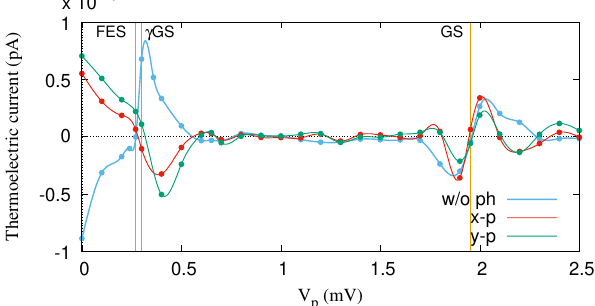
Figure 9. Thermoelectric current ( I L ) for the QD system without (w/o ph) (blue color) and with (w ph) x - (red color) and y -polarized (green color) photon fields. The photon energy is ¯ h ω γ = 1.68 meV, g γ = 0.05 meV, and ¯ n R = 1. The temperatures of the left and right leads are constant and fixed at T L = 1.16 K and T R = 0.58 K, respectively. The chemical potential of the leads are fixed at µ L = µ R = 1.2 meV. The golden vertical lines indicate the resonance condition for the GS at V p = 1.95 mV, and the Rabi-splitting states between the γ GS and the FES at V p = 0.271 meV. The weak external magnetic field is B = 0.1 T, and ¯ h Ω 0 = 2.0